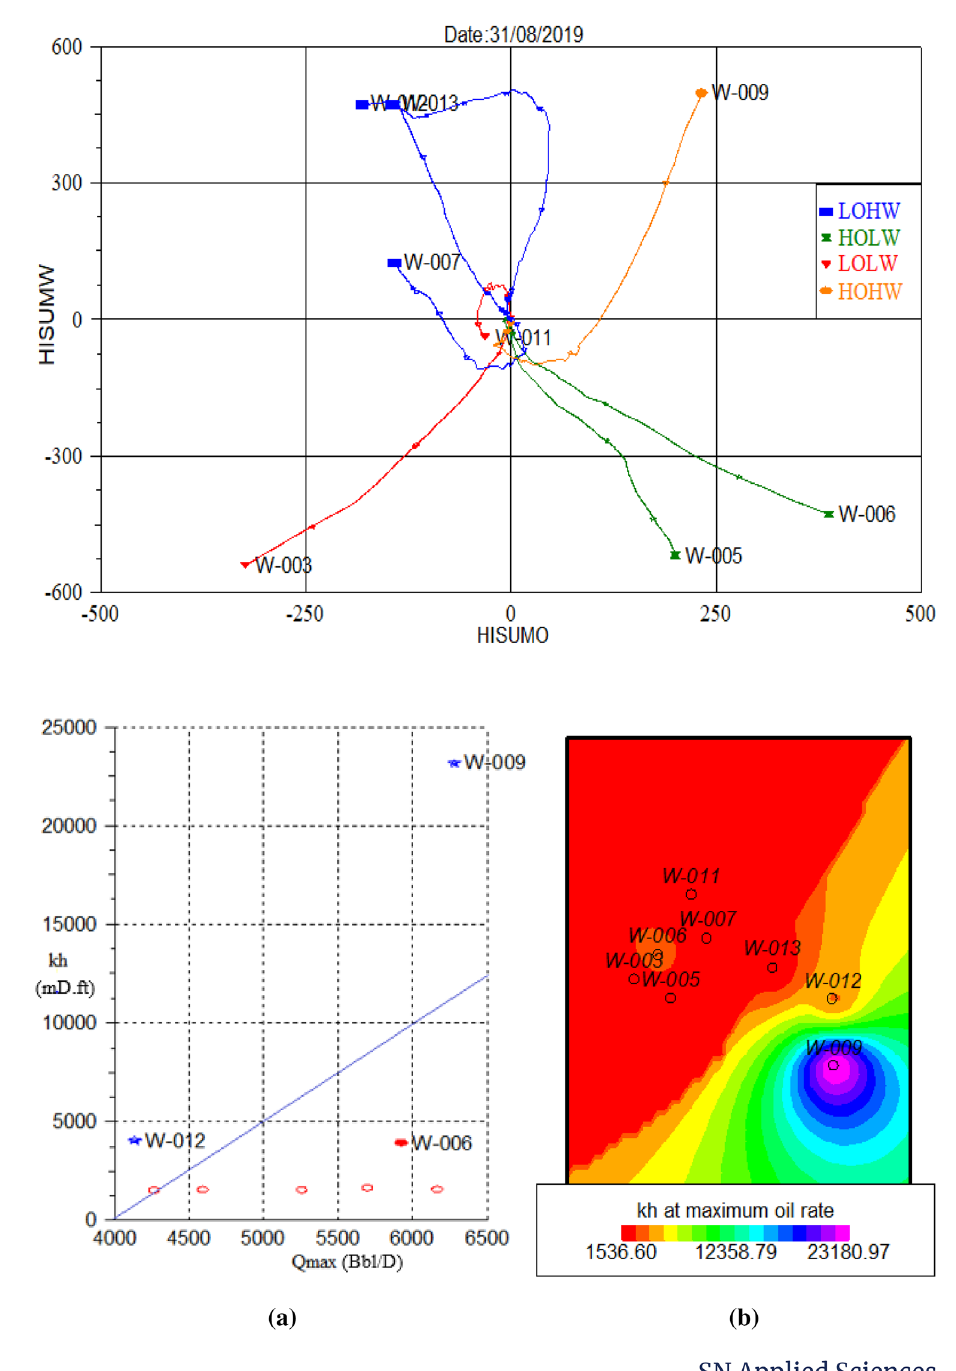
Fig. 4 HI plot of the case study field